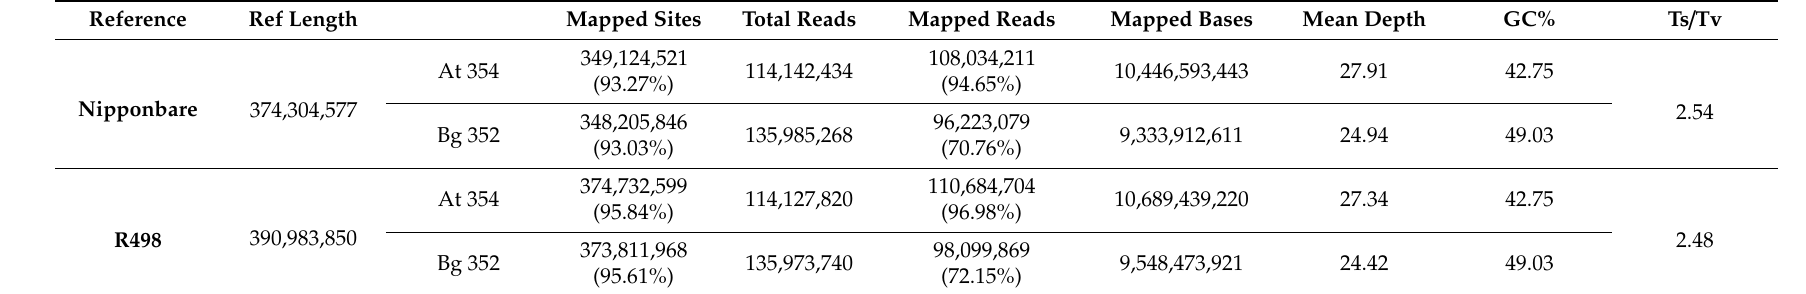
Table 1. Summary of sequencing